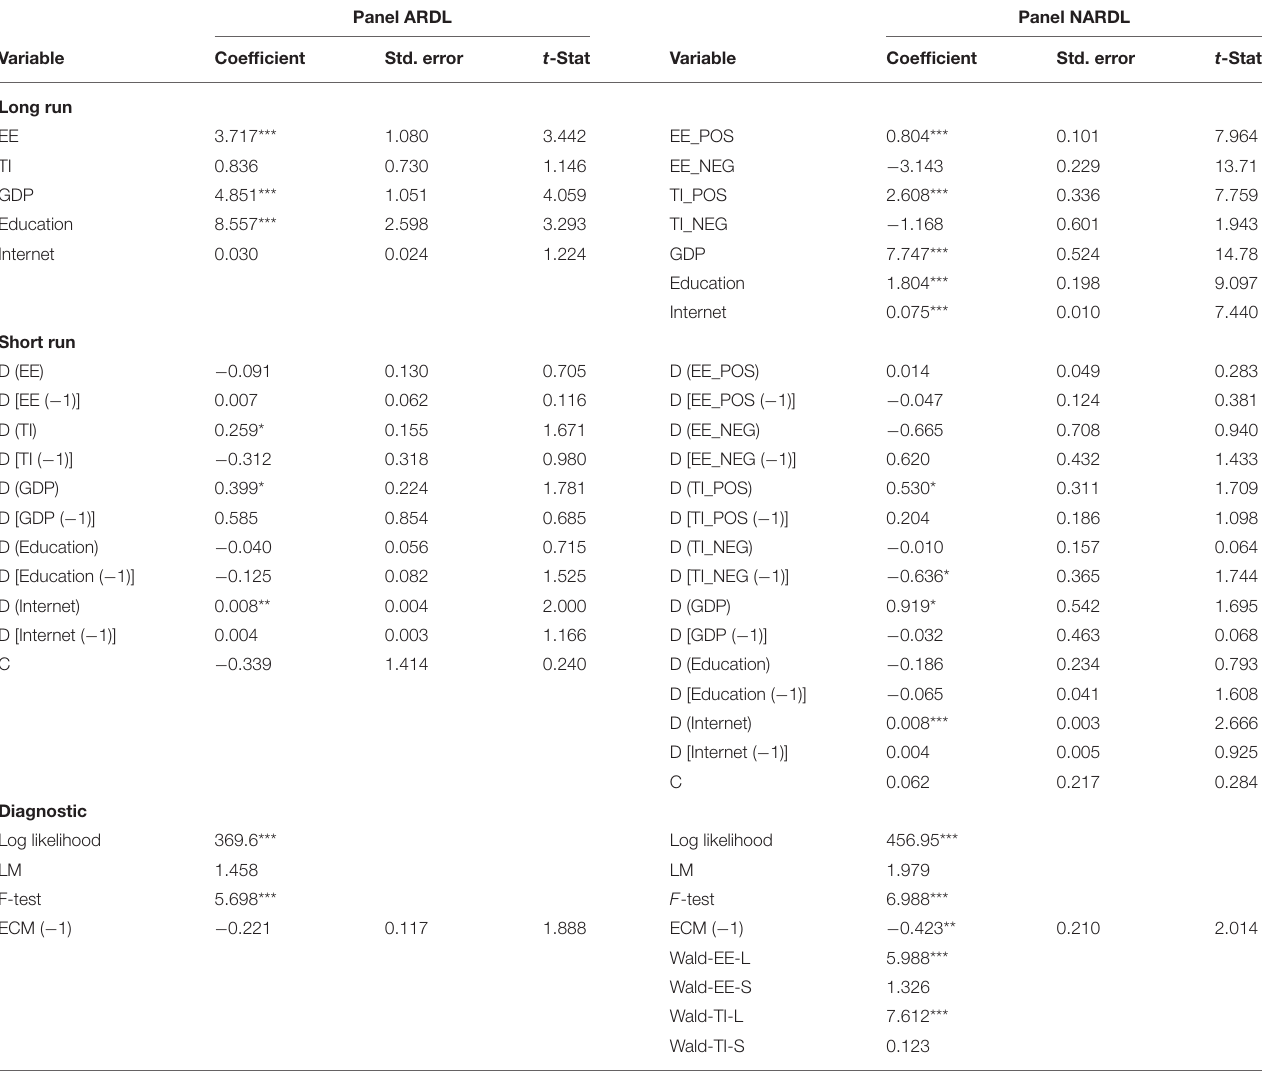
TABLE 3 | Panel ARDL and NARDL PMG estimation. Panel ARDL Panel